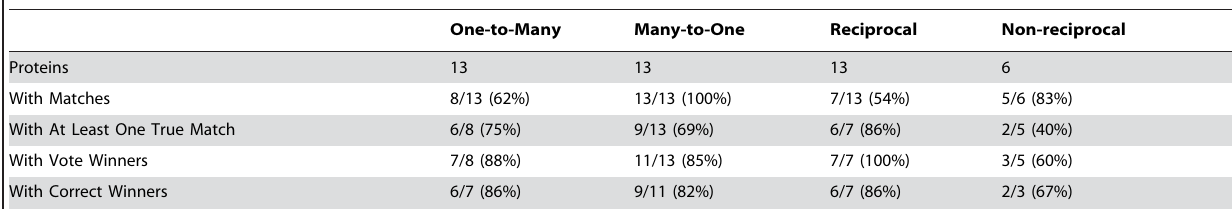
Table 5. ETA Annotation of Toronto Set.